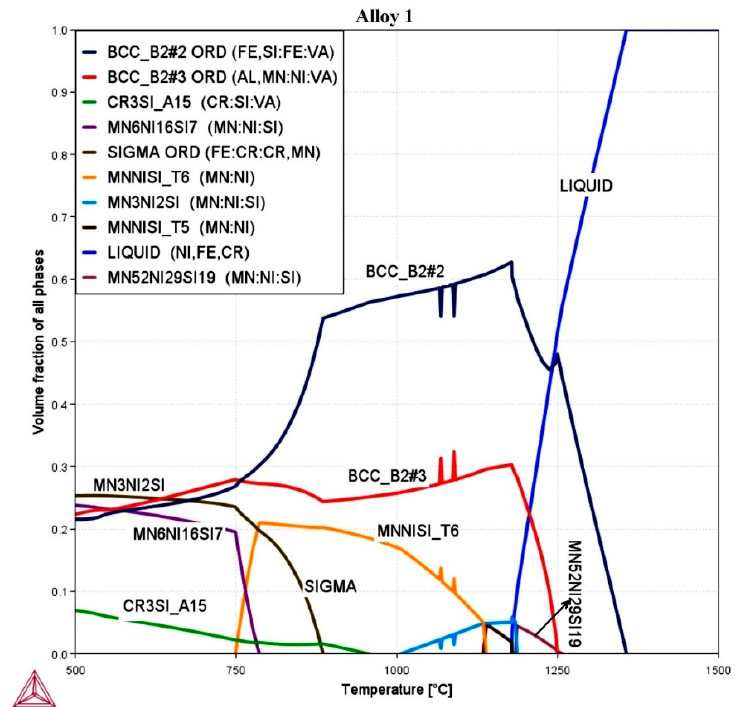
Figure 1. Phase diagram of Alloy 1 (Fe 30 Mn 15 Ni 20 Cr 15 Al 10 Si 10 ) HEA.